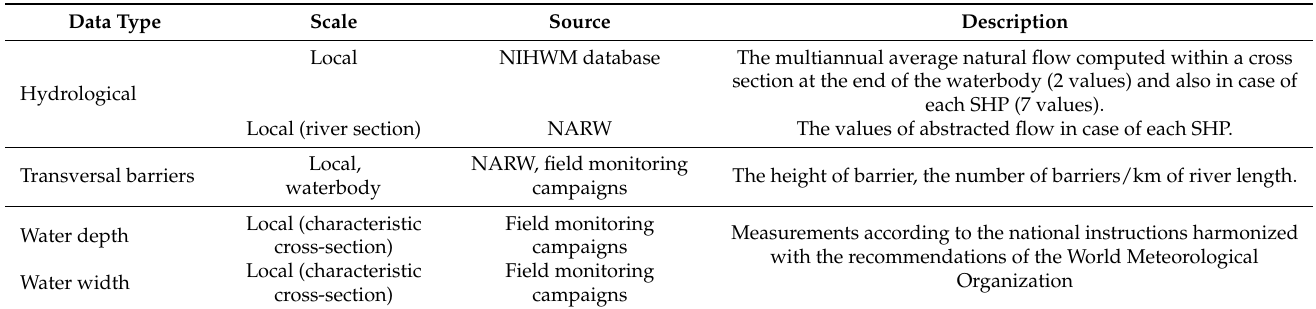
Table 1. The type and the sources of collected